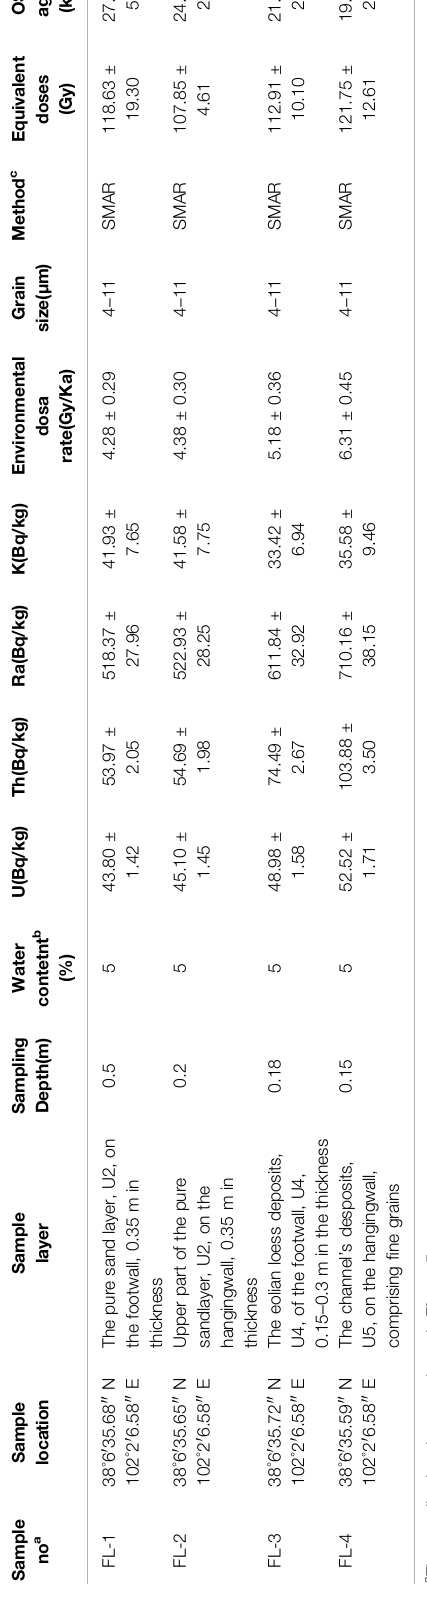
is available of this unit, with a dating result of 19.3 ± 2.5 ka BP ( Table 1 ). U6 is the top soil layer, dark in color and about 0.65 m in thickness. T A